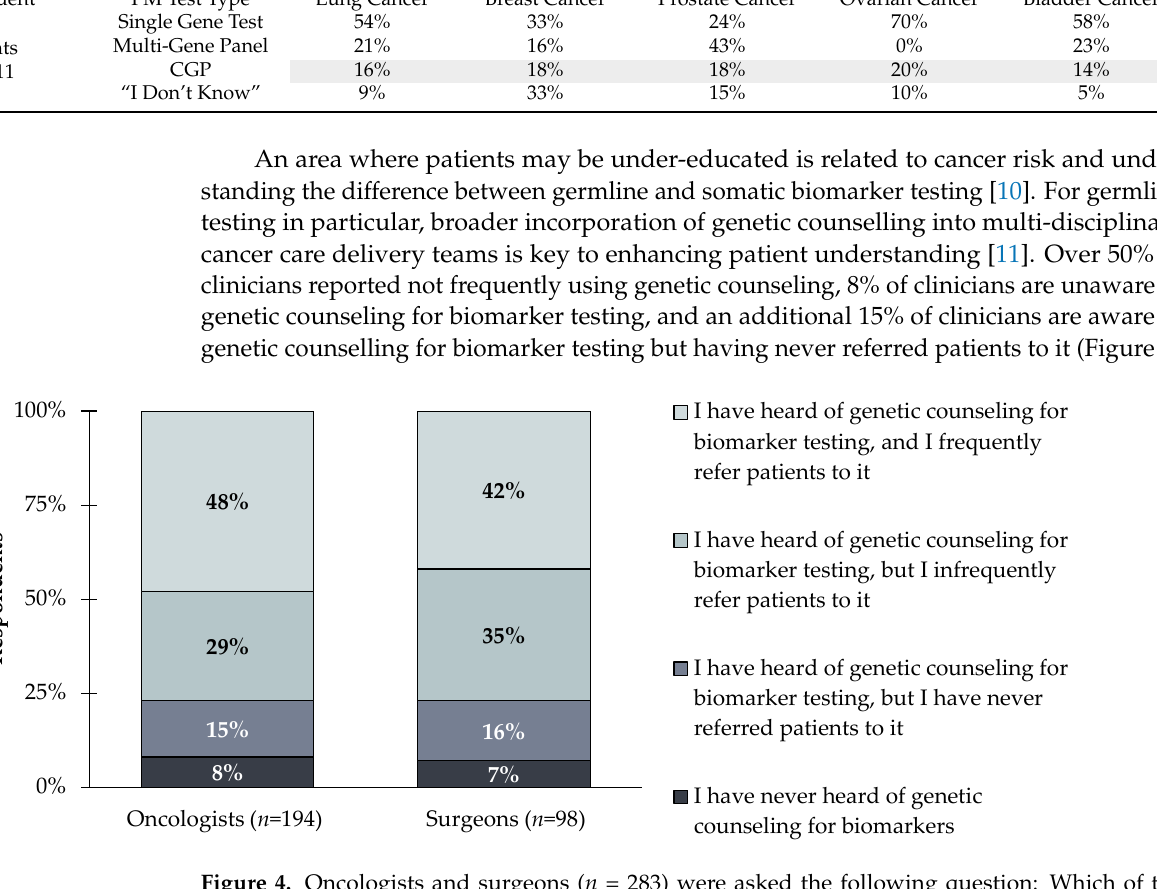
Figure 4. Oncologists and surgeons ( n = 283) were asked the following question: Which of the following best describes your level of awareness of genetic counseling to support biomarker test ordering and results reporting? 77% of both oncologist and surgeon respondents report to being aware of genetic counseling for biomarker testing and referring patients at some point either frequently or